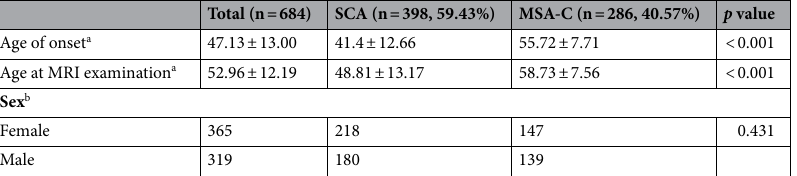
Table 1. Demographics of patients with MSA-C and SCA. a Mann–Whitney test. b Chi-square test. Numeric data are presented as mean ± standard deviation. MSA-C multiple system atrophy, cerebellar type; SCA spinocerebellar